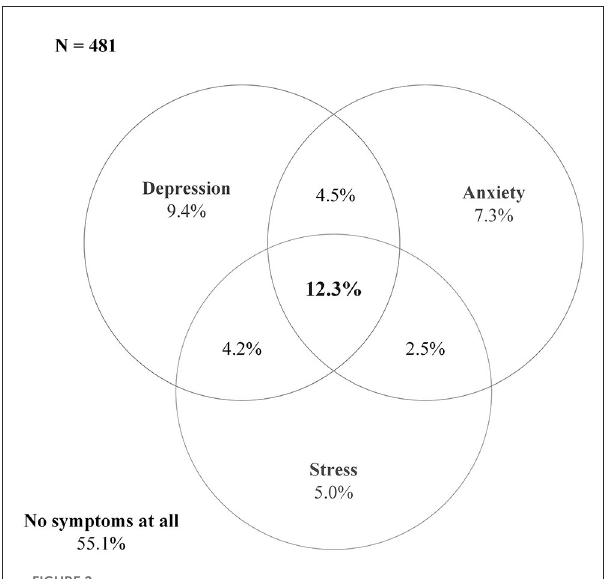
FIGURE2 Prevalence and coexistence of symptoms of depression, anxiety, and stress ( N = 481).